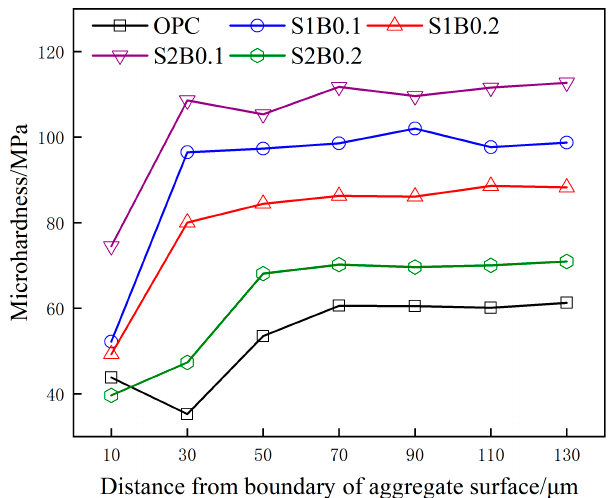
Figure 9. Microhardness curve of fiber concrete under an acid rain environment.